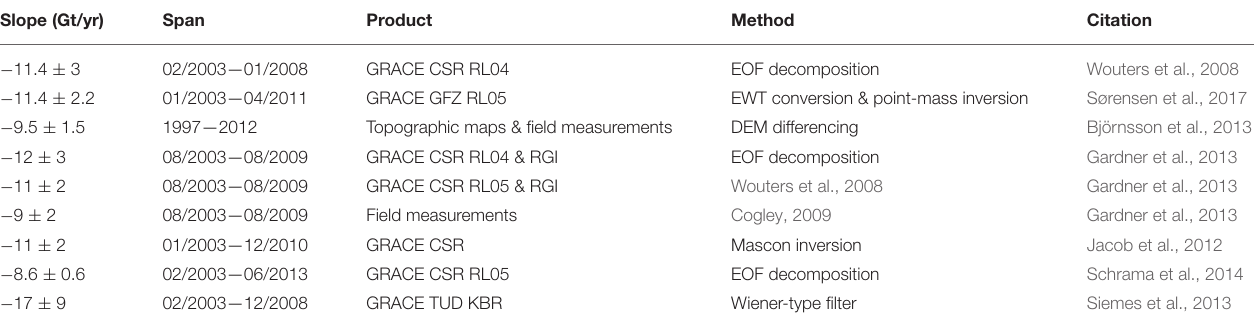
TABLE 1 | Comparison of recent prior mass balance estimates for Iceland.